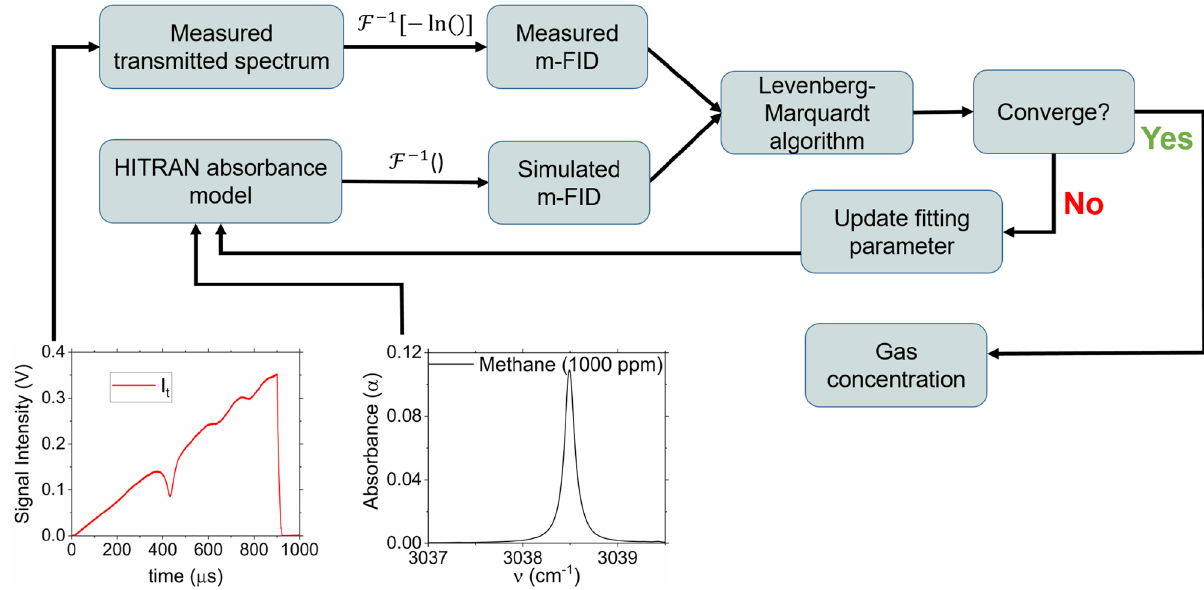
Figure 3. Flow chart illustrating the least-squares fitting of the m-FID signal to retrieve methane